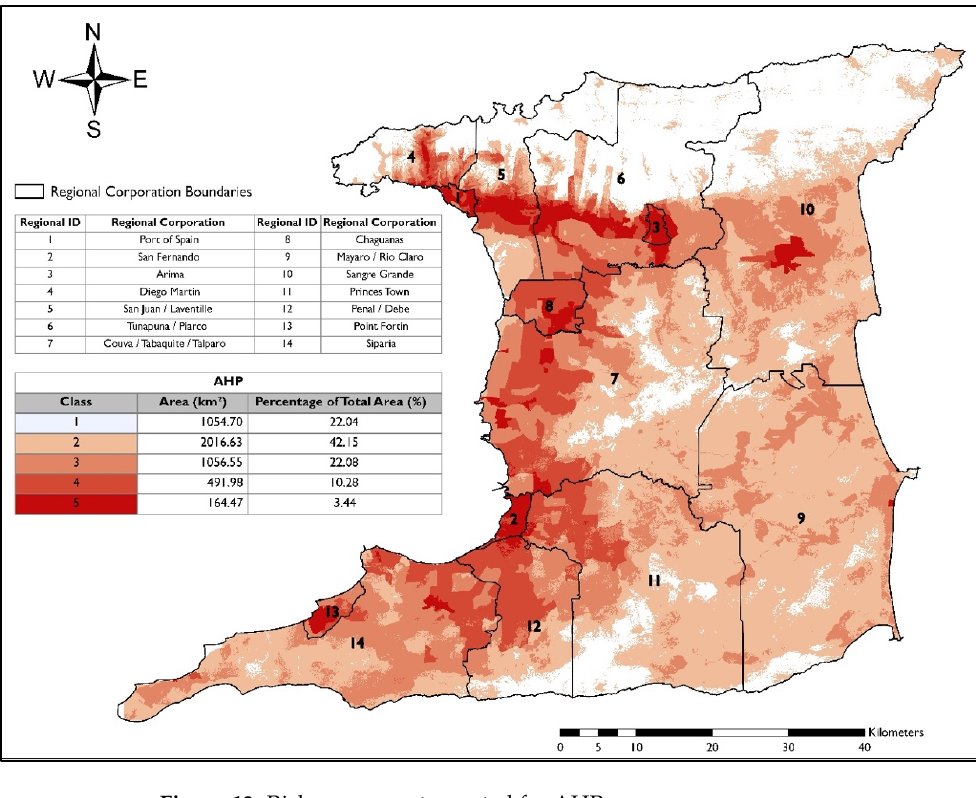
Figure 13. Risk assessments created for AHP.